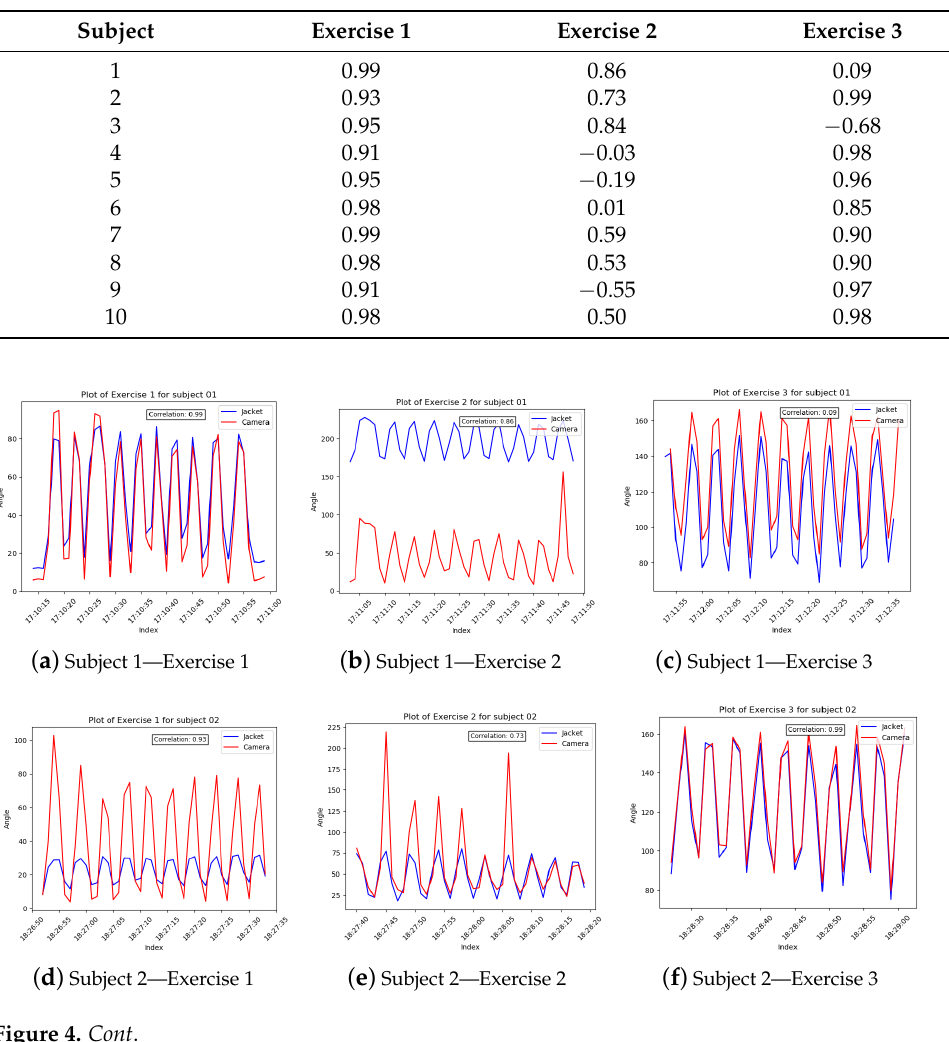
Table 3. Spearman’s Correlation coefficients for the wearable/visual validation tests.